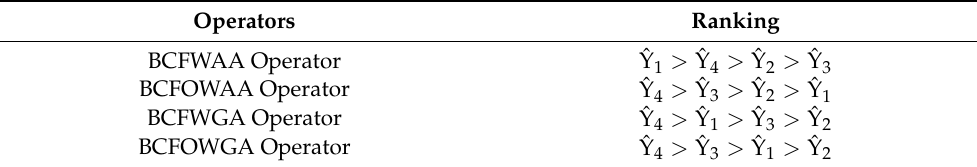
Table 8. Ranking